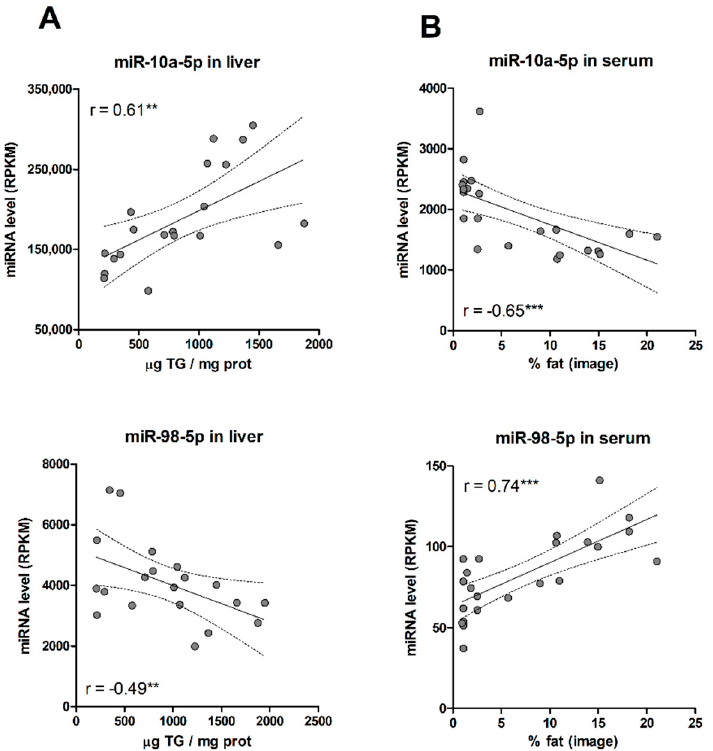
Figure 3. ( A ) Correlation between liver miRNA levels and tissue TG concentrations. ( B ) Correlation between serum miRNA levels and % fat in paired liver biopsies. **, p < 0.01; ***, p < 0.001.